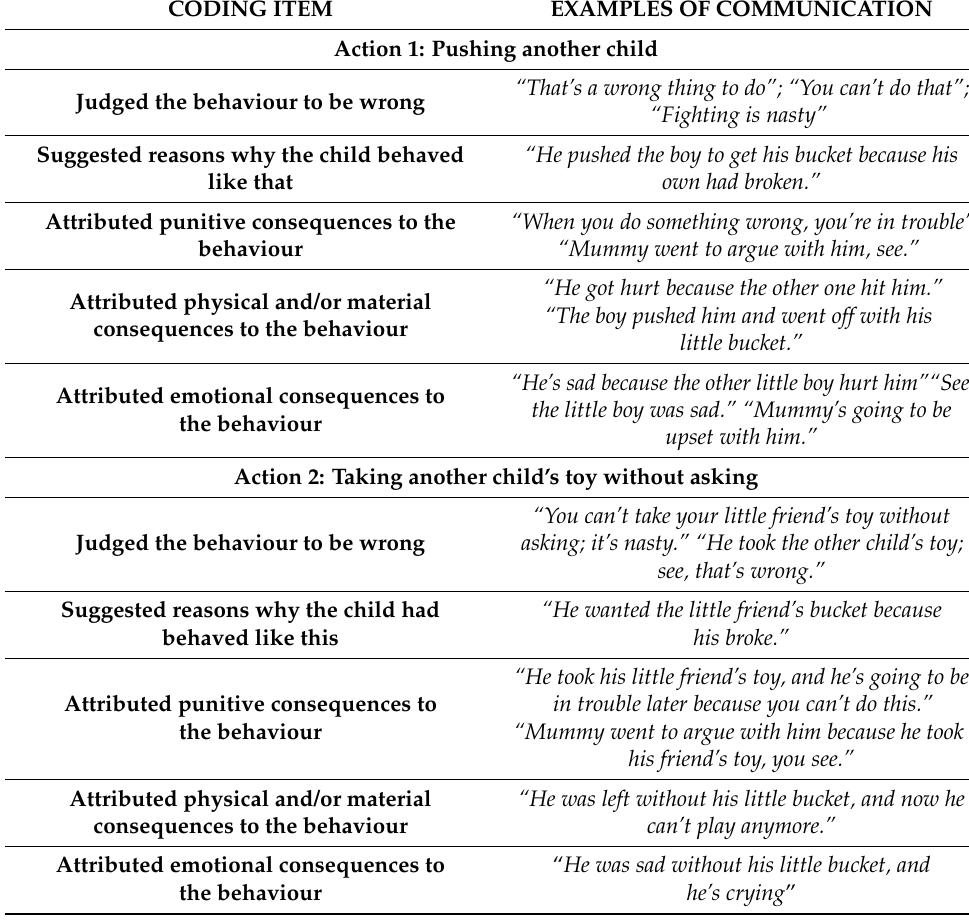
Table 1. Coding system for maternal moral